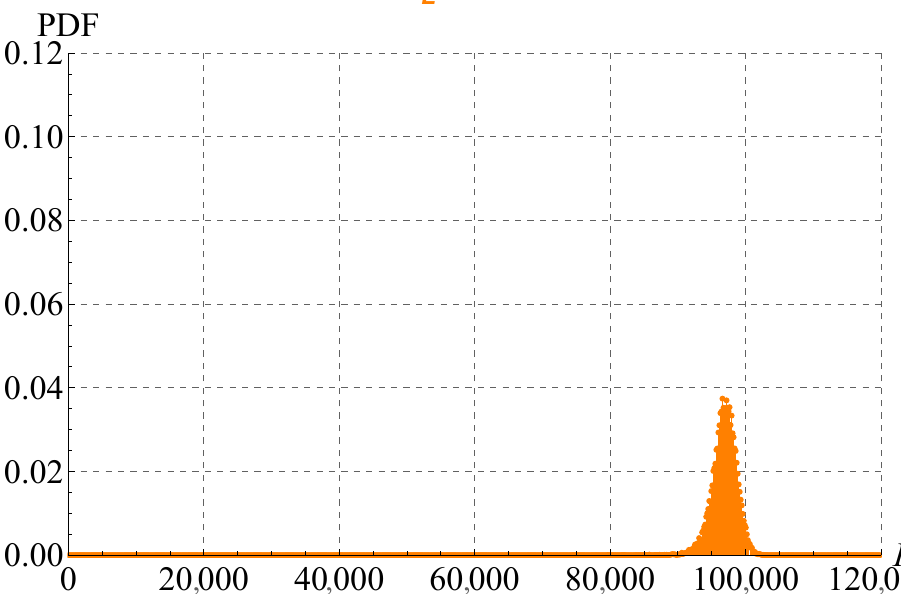
Figure 13. Probability density function (PDF), solution of Equation (36). Screenshoot at time ˆ t =